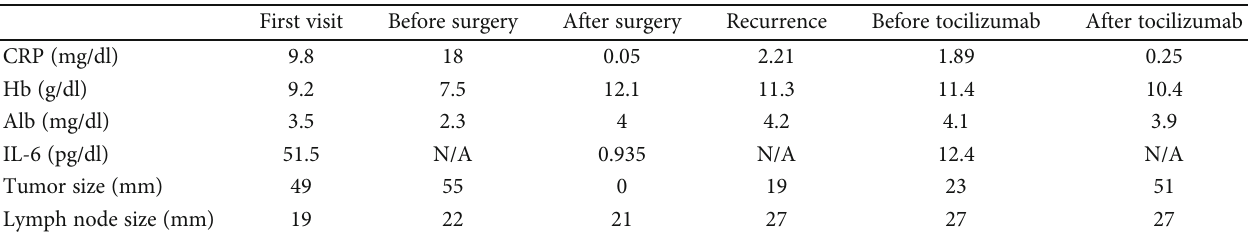
Table 1: The transition of laboratory parameters (e.g., C-reactive protein (CRP), hemoglobin (Hb), albumin (Alb), and interleukin-6 (IL-6)) and the size of the tumor and lymph node in our hospital during the fi rst visit. Before surgery